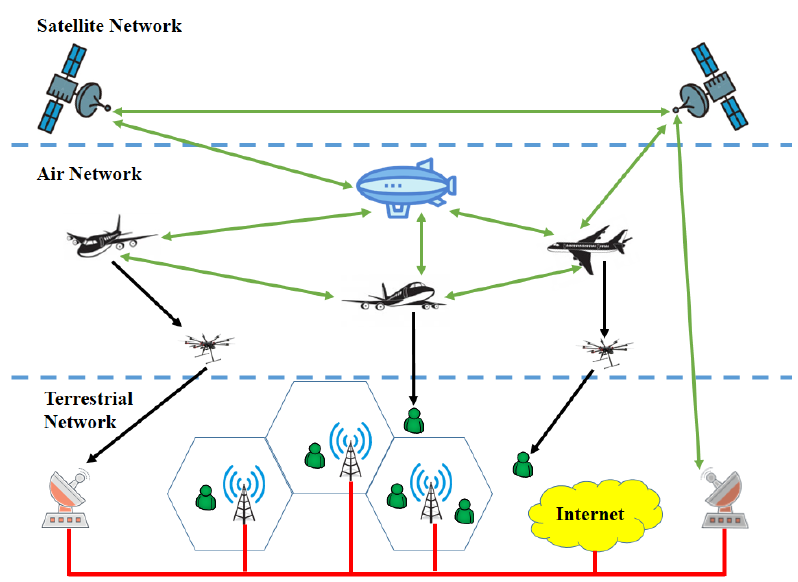
Figure 3. HSTN with aerial